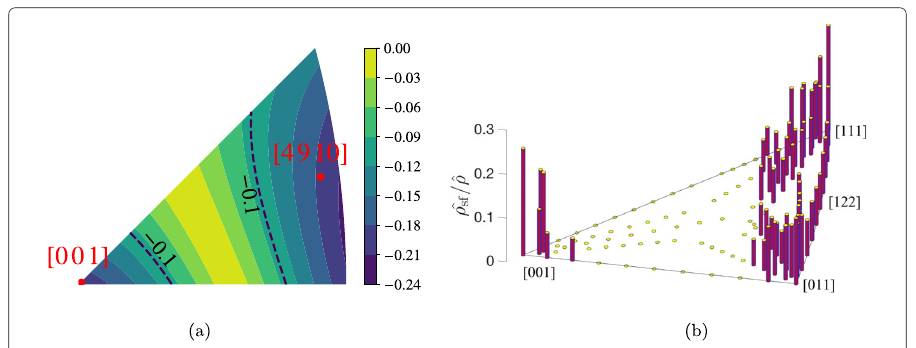
Fig. 5 a Minimum value of ( S i − 0.5 S i max ) for i = A2, A3 and A6 as a function of the loading orientation in